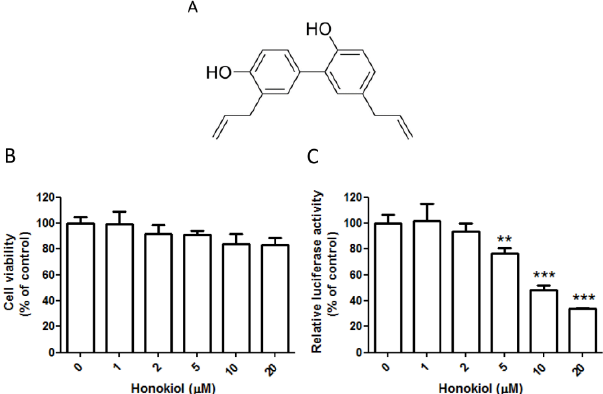
Figure 1. Honokiol inhibits DENV (dengue virus) replicon. ( A ) The chemical structure of honokiol; ( B ) BHK (baby hamster kidney) cells were treated with various concentrations of honokiol (1–20 μM) for 24 h, and the viability of BHK cells was measured by MTT assay; ( C ) The luciferase activity was measured in cell lysates after treatment with honokiol (1–20 μM) for 24 h. Data indicate the average value of triplicates (mean ± SD). ** p = 0.006; *** p < 0.001, as compared with the vehicle control.